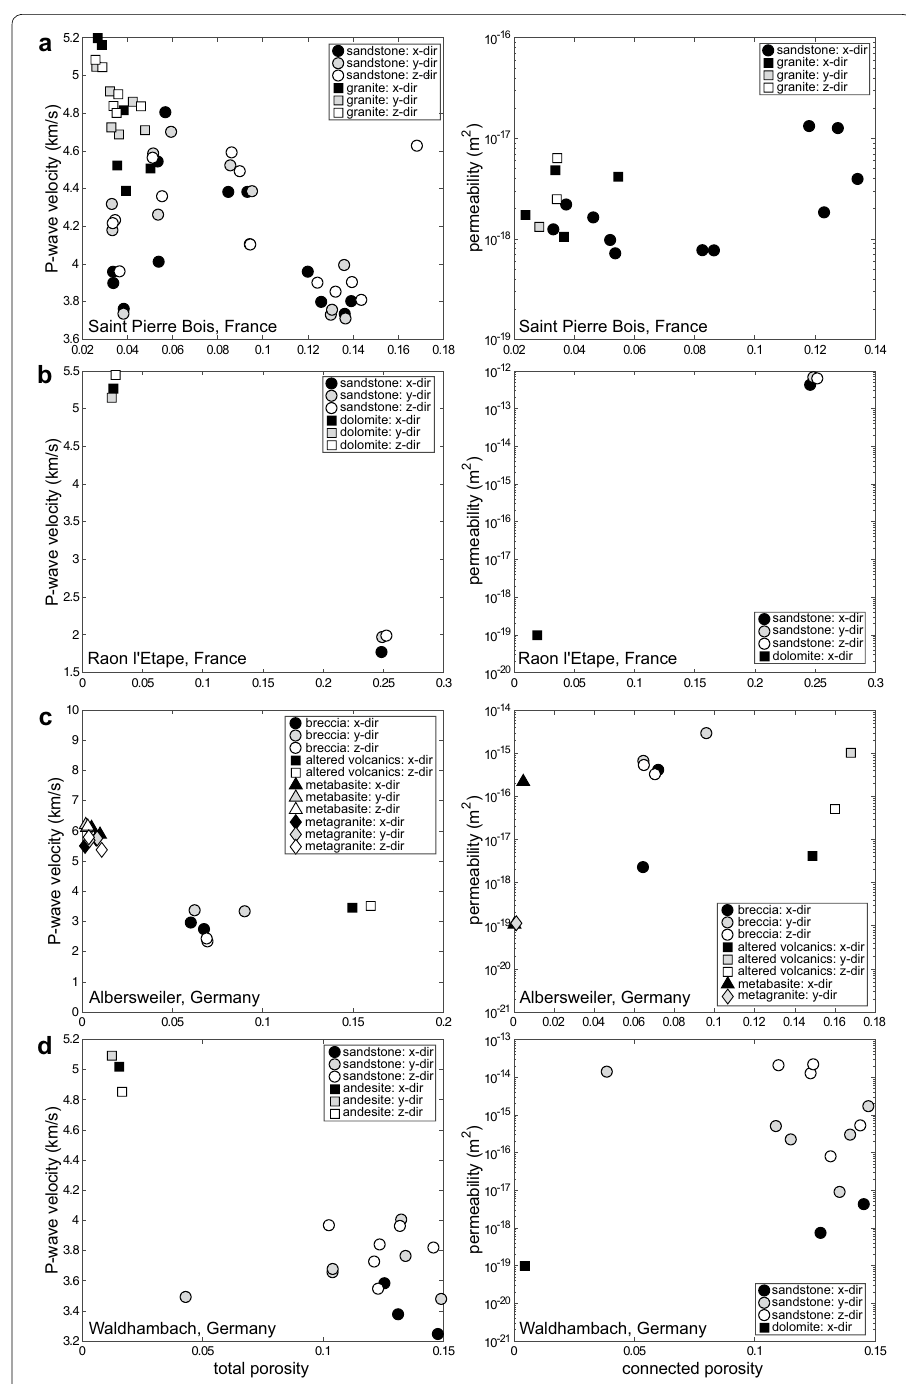
Fig. 6 P-wave velocity as a function of total porosity and permeability as a function of connected porosity for all rocks, organised by sample location. a Saint Pierre Bois. b Raon l’Etape. c Albersweiler. d